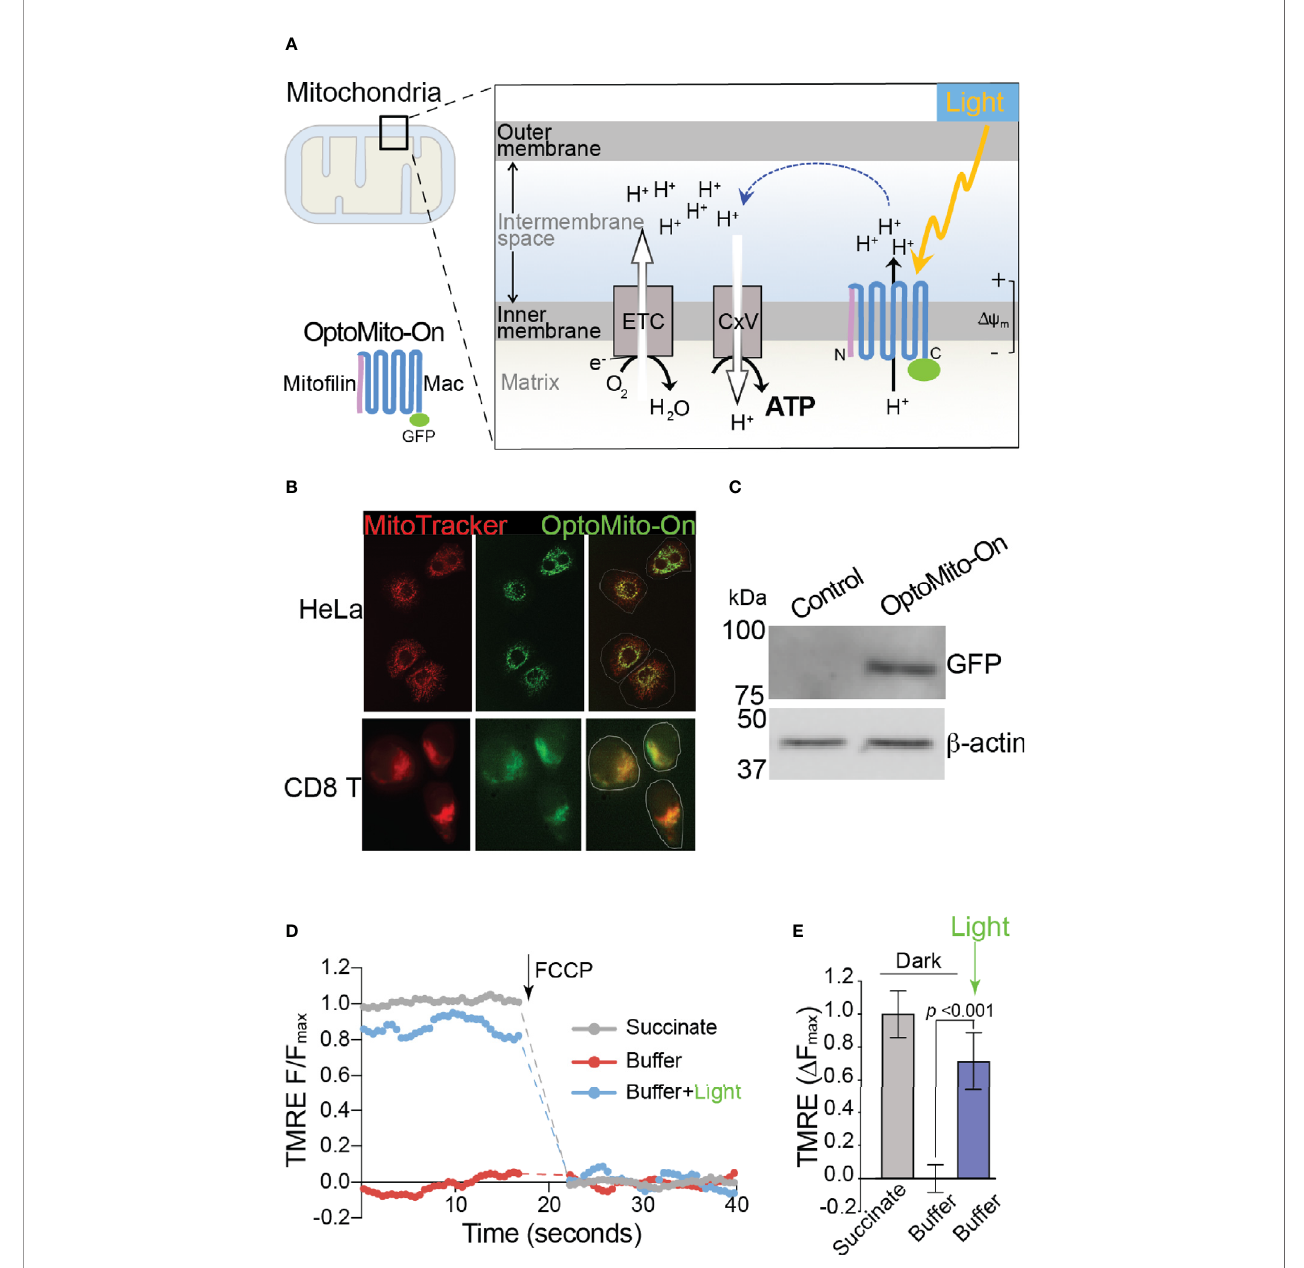
FIGURE 3 | Characterization of OptoMito-On. (A) Illustration of photoactivatable oxidative phosphorylation by OptoMito-On construct. (B) Images of HeLa cells and CD8 + T cells expressing OptoMito-On and stained with MitoTracker Red CMXRos. (C) Immunoblot comparing control HEK293T cell lysate and HEK293T OptoMito- On cell lysate. The full-length OptoMito-On construct is 82 kDa and probed for with an anti-GFP antibody. b -actin is used as loading control. Both images are from the same lanes on one membrane. (D) Representative TMRE fl uorescence trace of isolated mitochondria from OptoMito-On expressing HEK293T cells before and after addition of FCCP. Dashed lines indicate where FCCP was added. (E) Quanti fi cation of change in TMRE fl uorescence. Data shown as mean ± SEM and analyzed by One-Way ANOVA with a Bonferroni post-test (n =